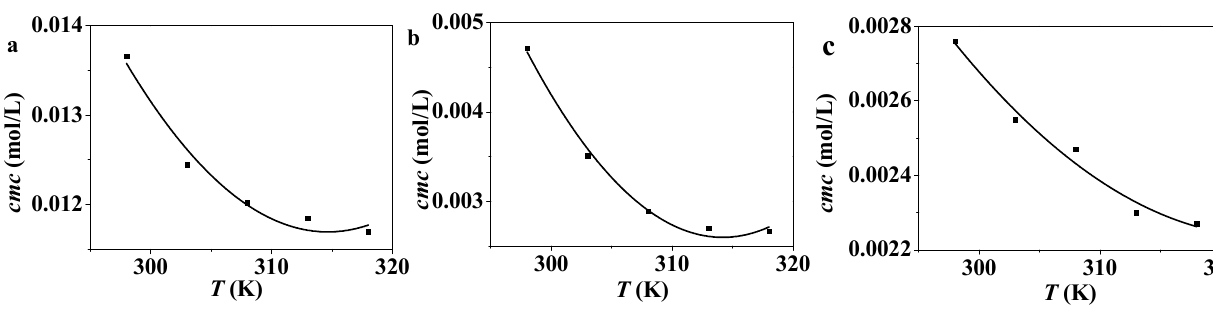
Figure 4. Plots of cmc versus temperature of C 12 MDB ( a ), C 14 MDB ( b ), C 16 MDB ( c